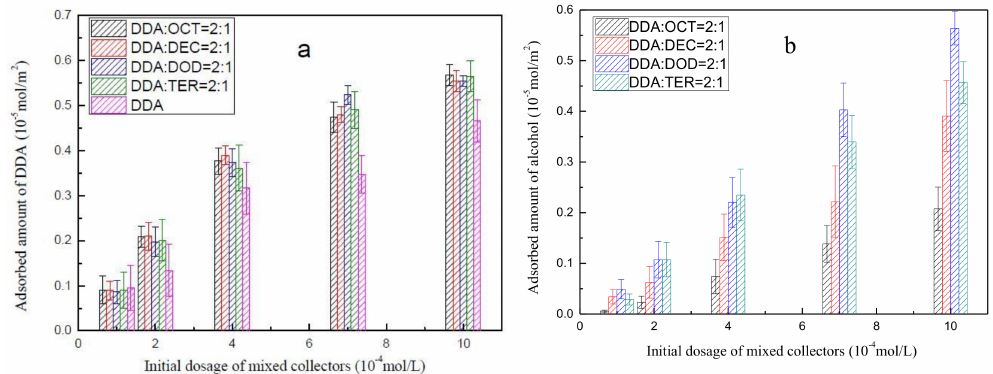
Figure 6. Adsorbed amount of DDA ( a ) and alcohol ( b ) on muscovite as a function of the initial dosage of mixed